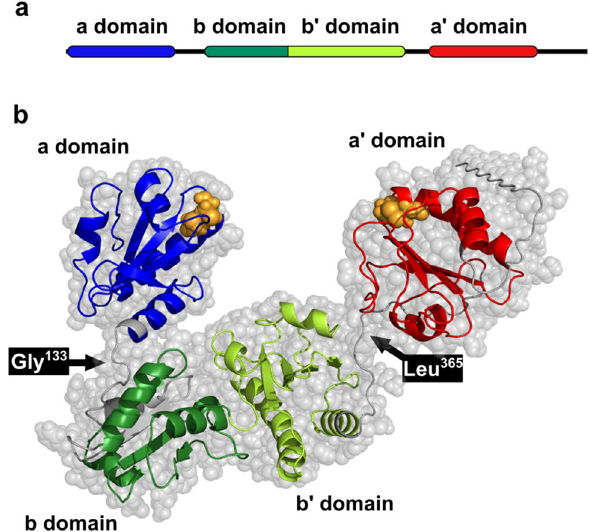
Figure 1. Multi-domain protein ER-60. ( a ) Four domains constituting ER-60. ( b ) Structural model of ER-60 based on a crystal structure (PDBID: 3F8U) 33 . PyMOL 39 was used to model the missing C-terminal residues and replace the mutated C60A with cysteine. In the ribbon model, the a domain in shown in blue, the b domain in green, the b ′ domain in yellowish green, and the a ′ domain in red. The other parts are gray. The reactive cysteines in the CGHC motif are orange. Gly 133 and Leu 365 are hinge regions between the a and the b domain, and the b ′ and the a ′ domain,